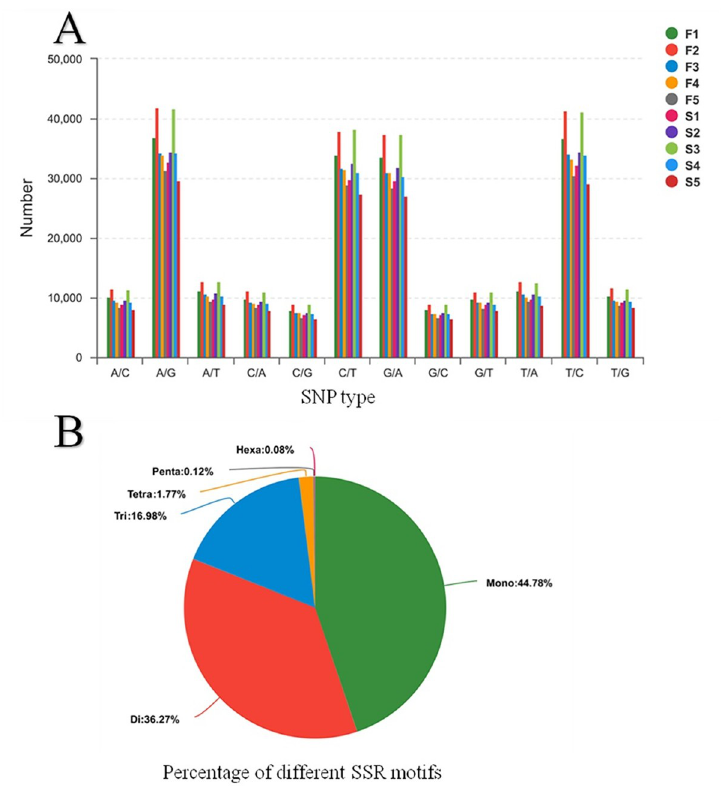
Fig 5. A, SNPs distribution in samples. The X-axis represents the type of SNP, and the y-axis represents the number of SNPs in different samples. B, the percentage of different SSR motifs. Different colors represent the number of different SSR types.